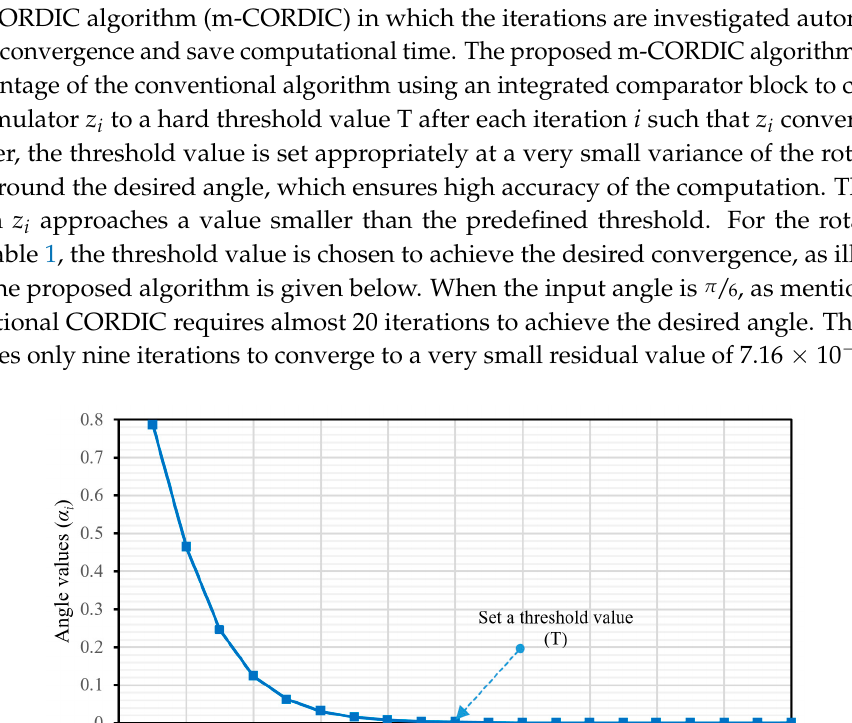
Figure 5. The hardware architecture of the pipelined modified coordinate rotation digital computer (m-CORDIC) algorithm with n-stage. For a sufficient number of iterations n , the accumulated scaling coefficient is